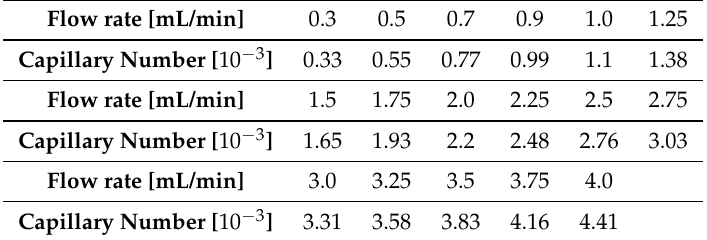
Figure 3. For the experiment with V = 3.75 mL/min: (at the top ) the trend of the optical signal after filtering and (at the bottom ) its spectrum. Table 2. Experimental campaign:Flow rate (mL/min) and Capillary